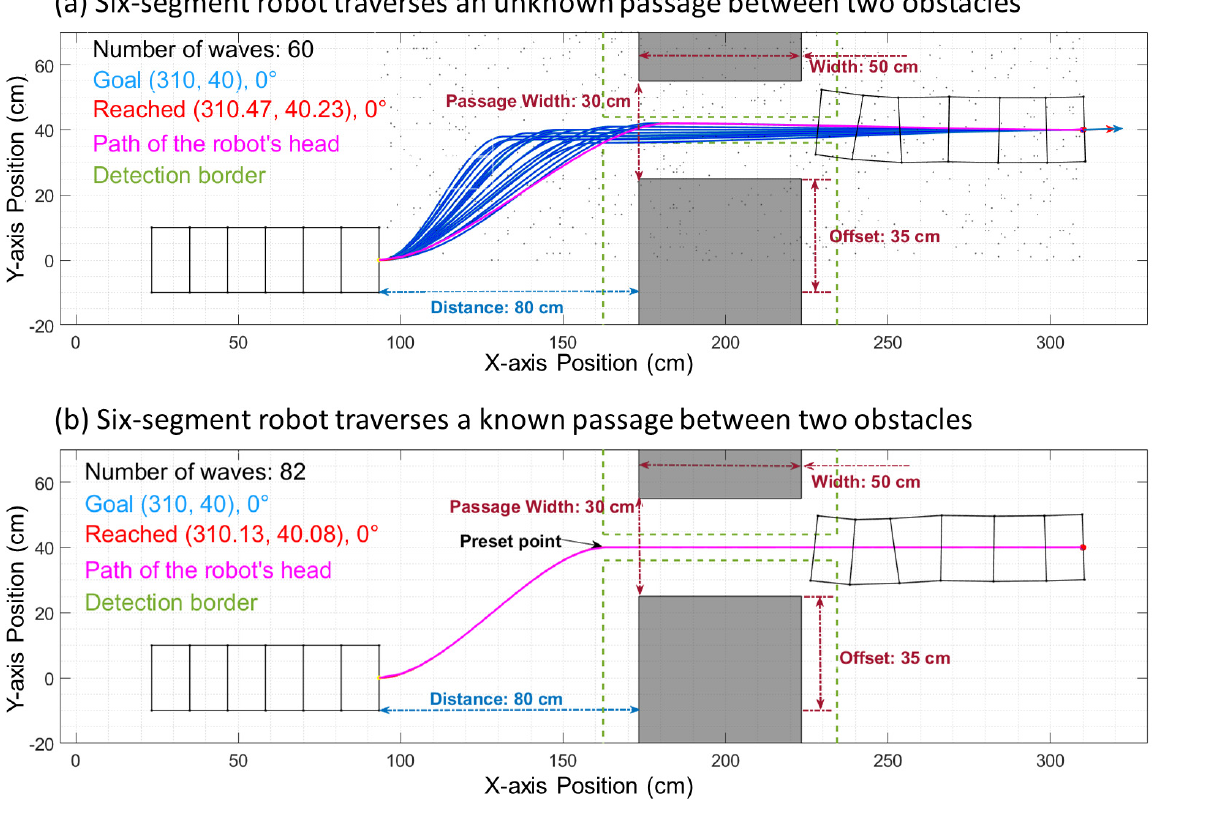
Figure 3. The six-segment robot passes through the obstacles that are arranged to form an offset passage. The dark rectangles represent the obstacles, and the green dashed lines are the detection borders. The gray dots in the background of ( b ) are the random waypoints used to search the whole space. The blue curves are the possible paths to the goal. Additionally, the pink curve is the final path that the robot chose. ( a ) The robot follows the path, successfully traverses an unknown passage between the obstacles, and reaches the goal. ( b ) The robot traverses a known passage with a preset waypoint.